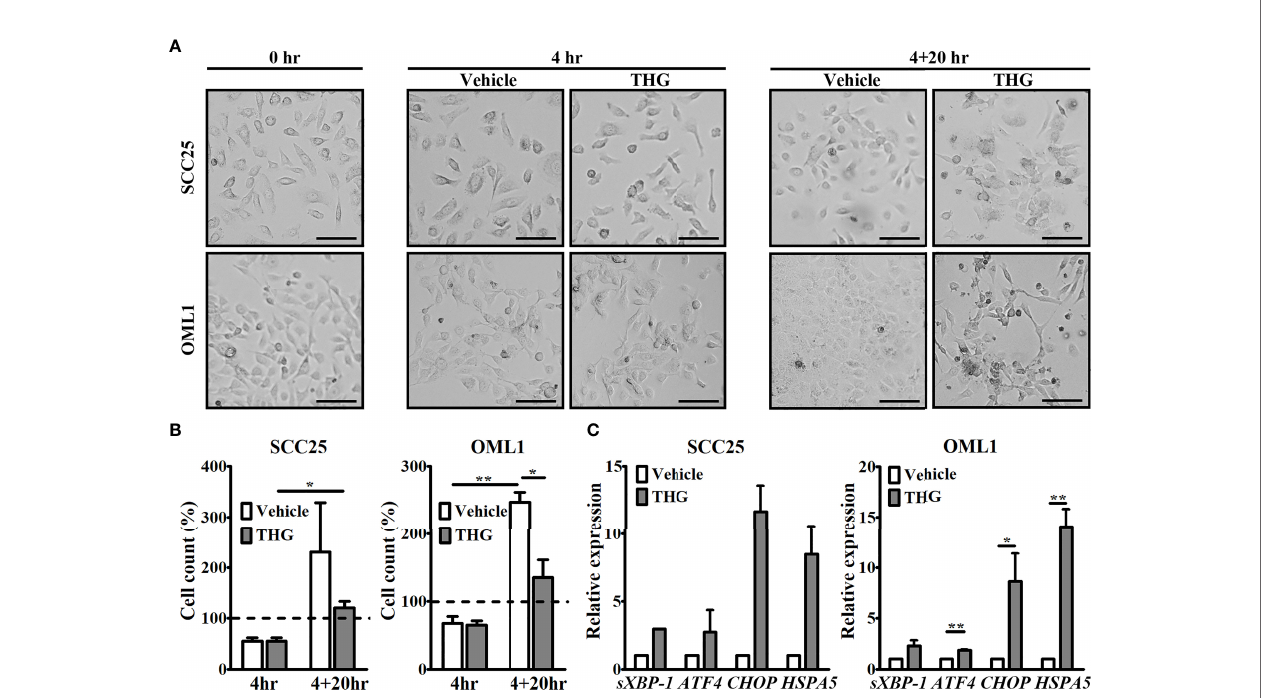
FIGURE 1 | Thapsigargin (THG) induced responses of endoplasmic reticulum (ER) stress in tumor cells. (A) Both SCC25 and OML1 cells were treated with vehicle or 2 m M THG for 4 hours and then incubated in renewed medium for additional 20 hours. The morphology of both cell lines under light microscopy before and after treatment was shown. Scale bars represented 100 m m. (B) The numbers of live SCC25 and OML1 cells, determined by trypan blue stain, at 4 hours and 4 + 20 hours after treatment. Initial seeding cell number was set as 100%. (C) At the end of culture (4+20 hours), both SCC25 and OML1 cells were harvested to evaluate expression of ER stress-related genes, including spliced X-box binding protein 1 ( sXBP-1 ), activating transcription factor 4 ( ATF4 ), C/EBP homologous protein ( CHOP ), and heat shock protein family A member 5 ( HSPA5 ), by quantitative reverse transcription polymerase chain reaction (qRT-PCR). The relative expression of these genes was normalized to glyceraldehyde-3-phosphate dehydrogenase ( GAPDH) following 2 - DD C T method. All data were from two biological replicates and presented as mean ± SD. * p < 0.05, ** p <